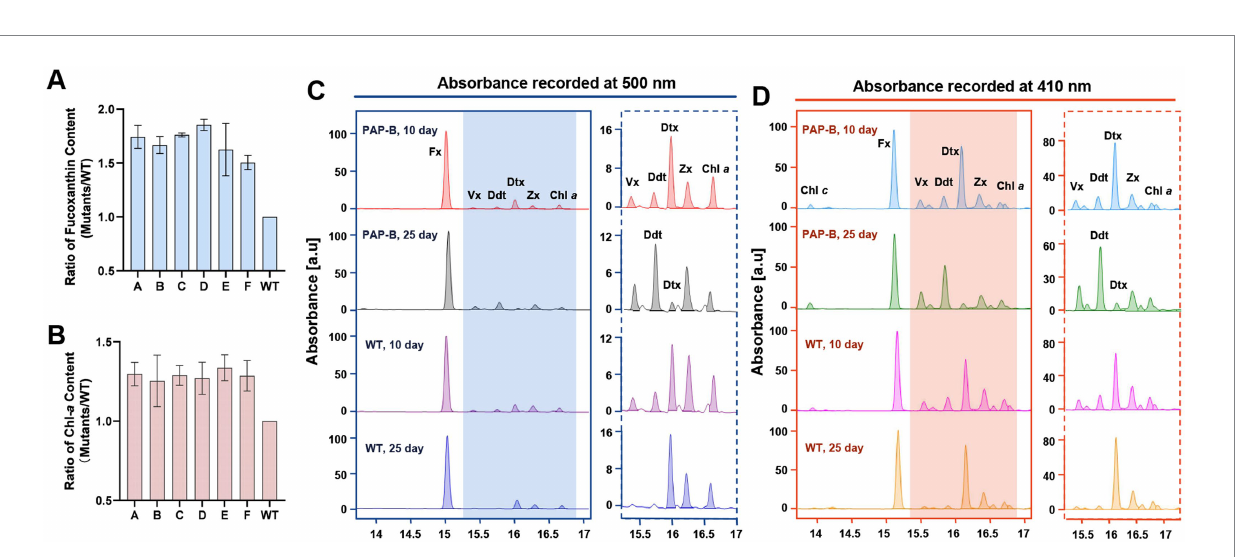
FIGURE 4 Pigment composition of the mutant PAP-B and WT. (A,B) The ratio of fucoxanthin and Chl-a content between the mutant and WT after 14 days. (C,D) The pigment compositions of PAP-B and WT were analyzed by HPLC at different culture times, and the absorption peaks at 500 and 410 nm are